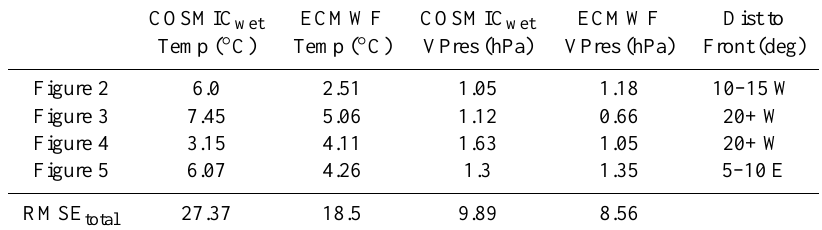
Table 2. Root mean squared error for COSMIC wet and ECMWF data sets for the temperature (Temp) and vapour pressure (VPres). The approximate distance to a front is also shown in degrees. The letter indicates whether the front is to the west (W) or east (E) of Macquarie Island. The bottom row shows the RMSE total for all the 35 co-located profiles.